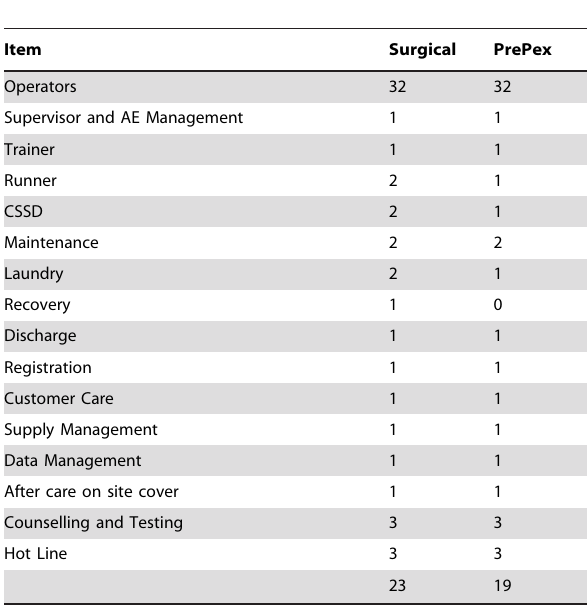
Table 2. Comparative HR needs in the SMC programme, Uganda PrePex study